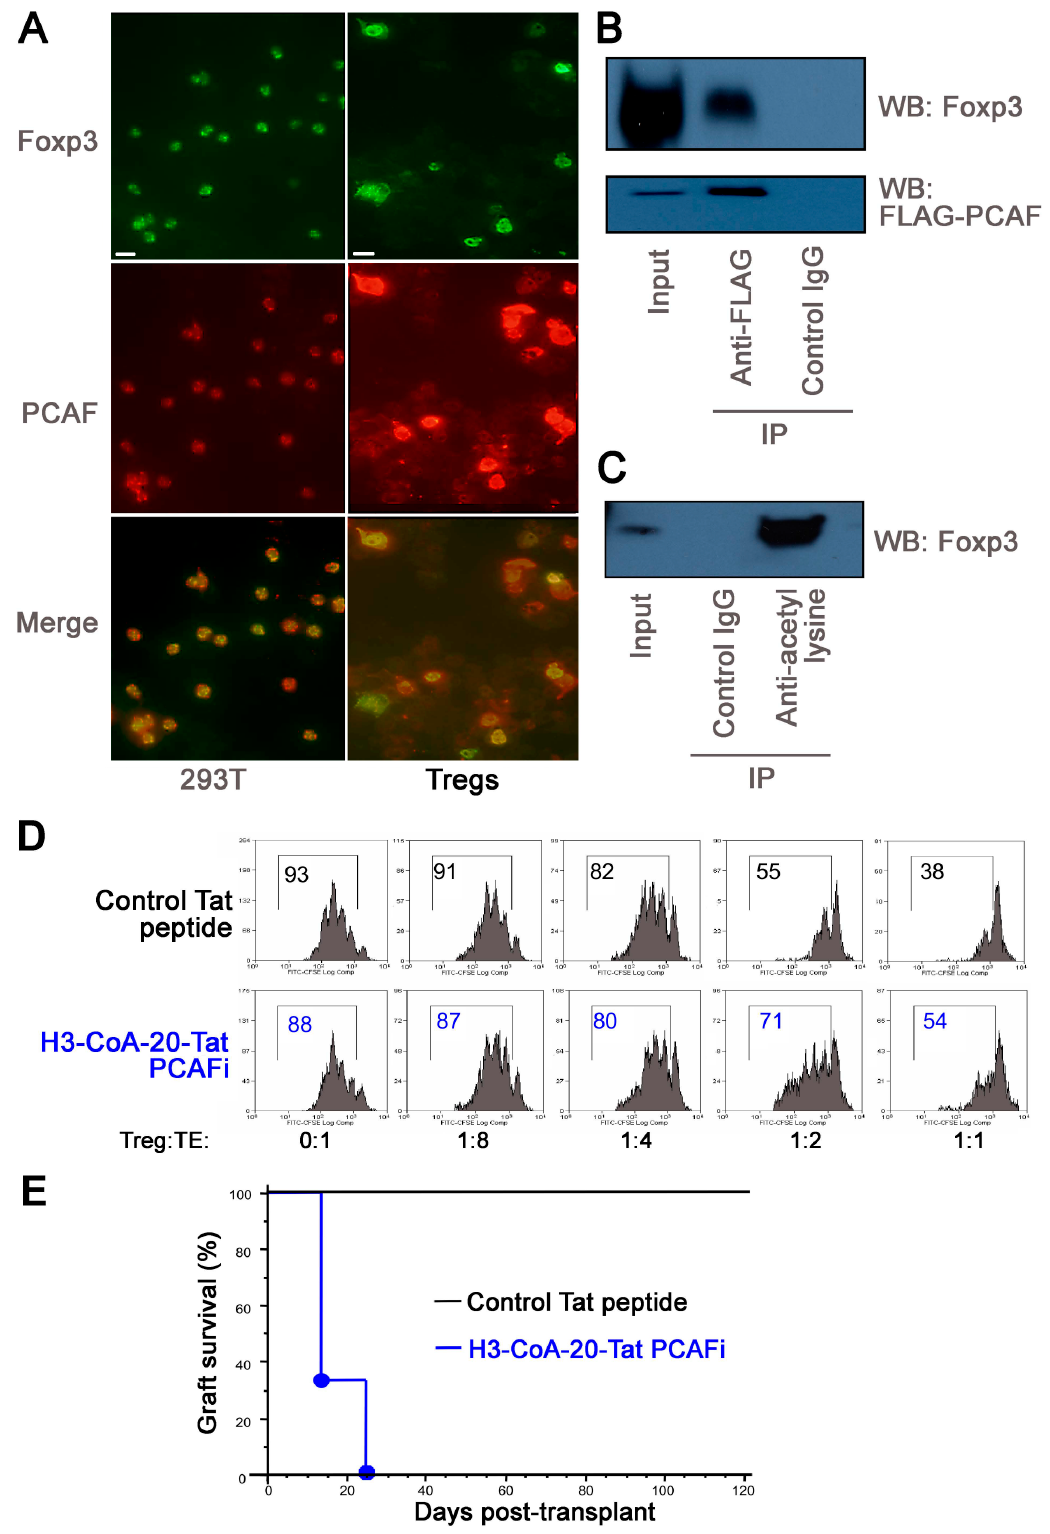
Figure 4. PCAF helps maintain Treg stability under TCR stimulation. ( A ) Colocalization of Foxp3 and PCAF in nuclei of transfected 293T cells, and colocalization of endogenous Foxp3 and PCAF in nuclei of Tregs; Foxp3 (green), PCAF (red) and cells with co-localization appear in yellow. ( B , C ) 293T cells were transfected with Foxp3 and PCAF-Flag expression vectors for 48 h. Scale bars = 10 microns. ( B ) Cell lysates were immunoprecipitated with anti-Flag (Ac-K) or anti-rabbit-IgG Abs followed by